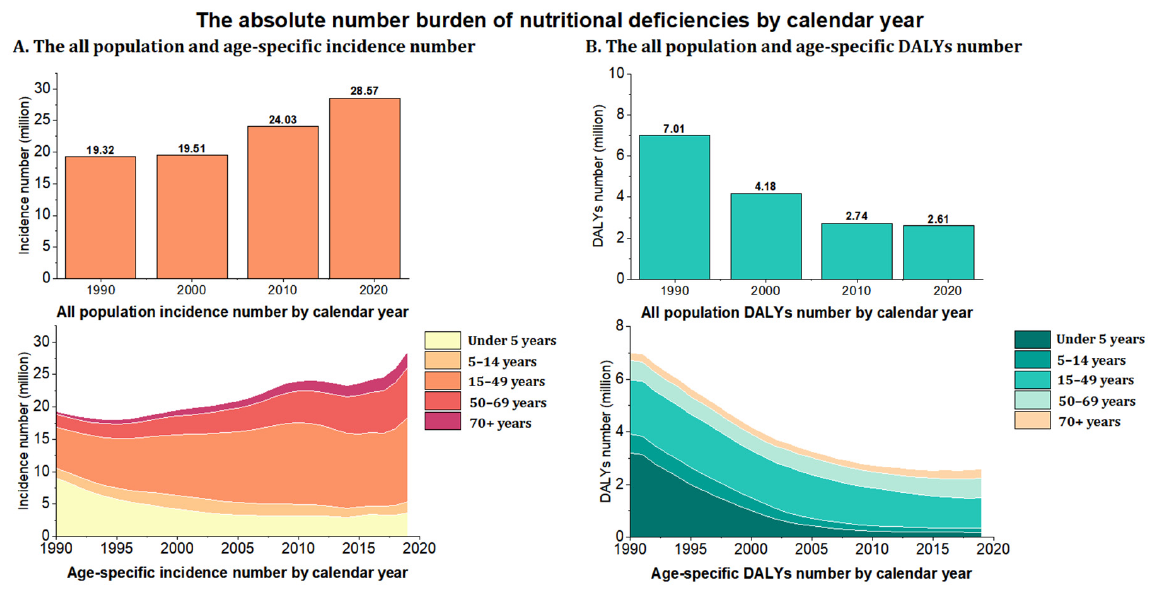
between 1990 and 2019 (EAPC: − 2.63 ( − 3.10 to − 2.16)). From 1990 to 2019, the age-stand- ardized incidence rate of overall nutrition deficiency increased significantly in people aged 15–49 (EAPC: 1.51 (1.13 to 1.90)), 50–69 (EAPC: 1.58 (1.35 to 1.80)), and over 70 (EAPC: 1.66 (1.46 to 1.87)) (Table 1 and Figure 2A). In 2019, people aged over 70 (345.89 per 100,000) had the highest rate of DALYs from overall nutritional deficiency. Nonethe- less, the rate of DALYs from overall nutritional deficiency declined between 1990 and 2019 in speci fi c age groups, especially in children under the age of fi ve (EAPC: − 10·53 [ − 11.00 to − 10.06]) (Table 1 and Figure 2B). Figure 1. The absolute number of nutritional deficiencies from 1990 to 2019 in China. ( A ) Incidence; ( B ) DALYs. DALYs = disability-adjusted life-years. The age-standardized incidence rate of nutritional deficiencies remained stable from 1990 to 2019 [EAPC: 0.11 ( − 0.19 to 0.41)]. The age-standardized DALY rate decreased sig- nificantly over the same period, by an average EAPC of − 5.54 ( − 5.96 to − 5.12); this corre- sponded to a decrease from 629.02 cases per 100,000 people to 174.78 cases per 100,000 people (Table 1 and Figure 2A). In 2019, children under the age of five had the highest estimated age-standardized incidence rate (4414.22 per 100,000); however, the EAPC in this age group decreased